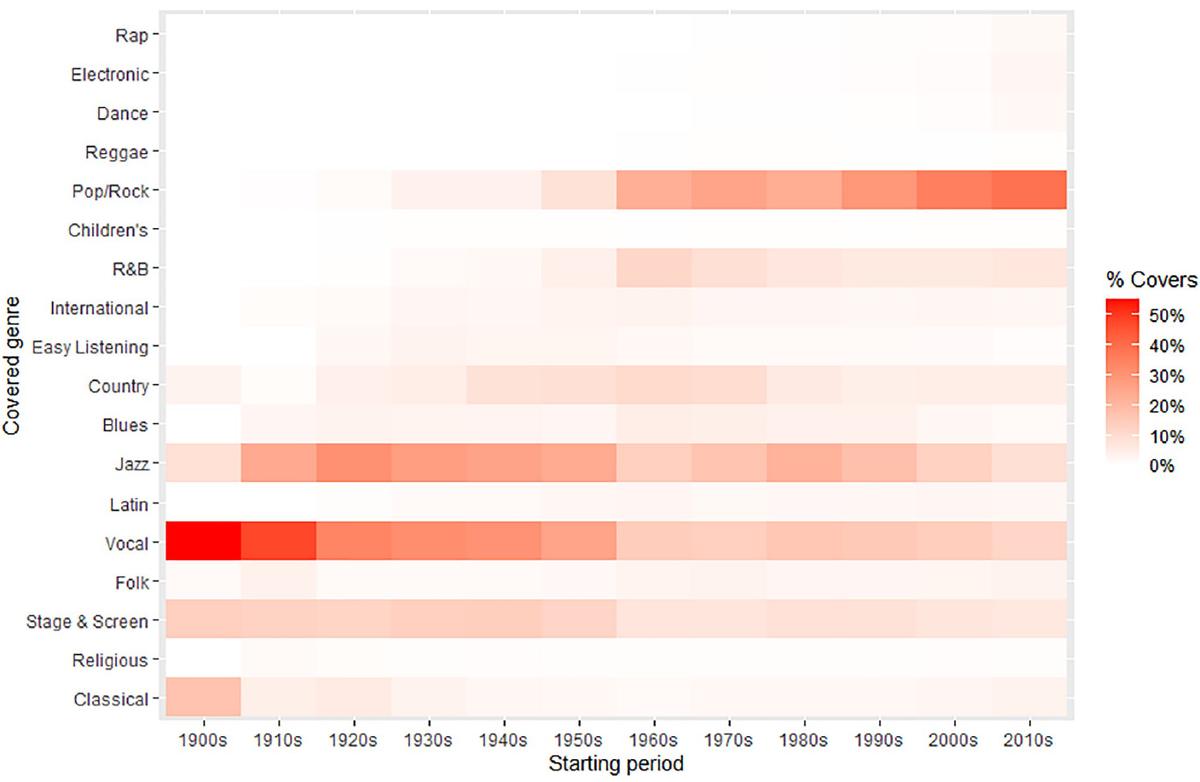
Fig 8. Heat map with the percentage of covered music genres by